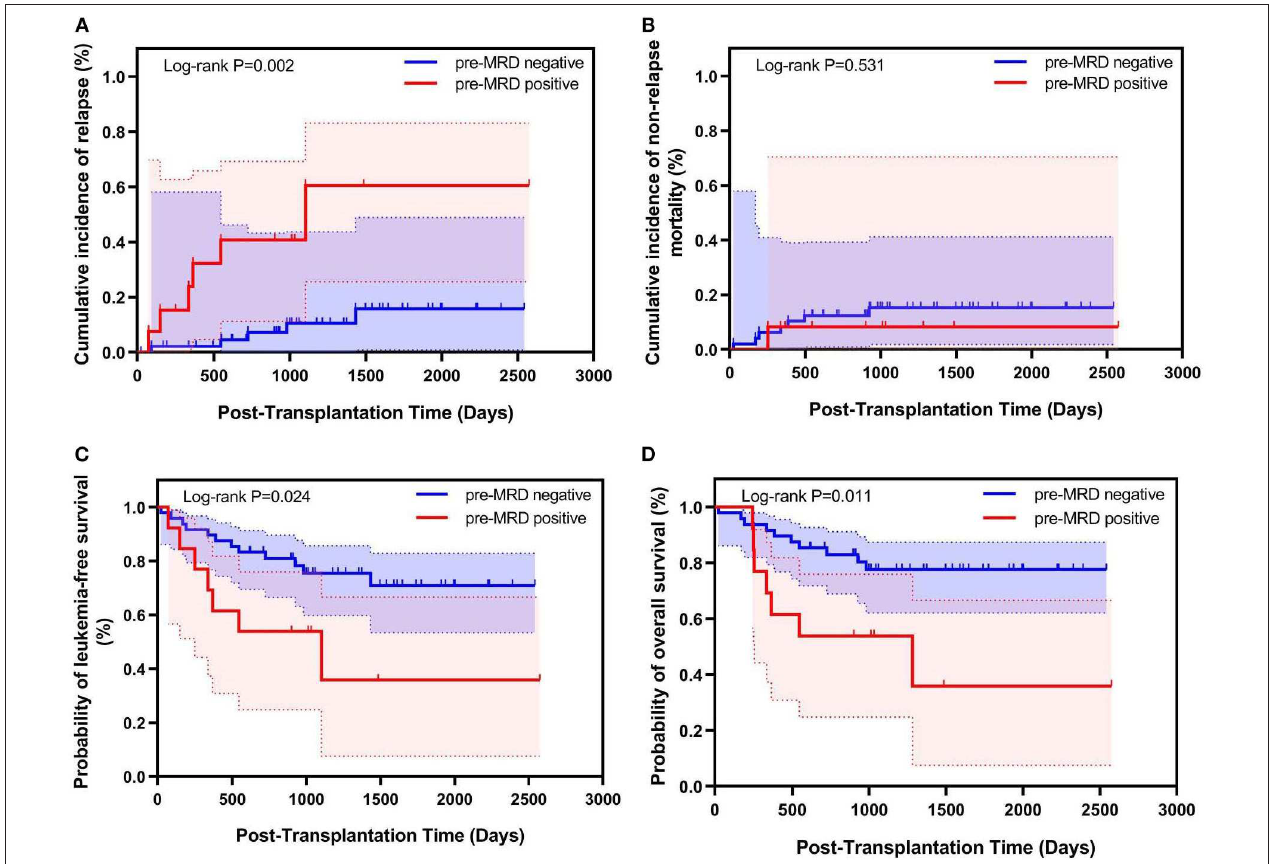
FIGURE 2 | Relationship between pre-transplantation MRD and transplant outcomes for Ph-positive ALL patients who underwent MSDT ( n = 61). Kaplan–Meier estimates of (A) cumulative incidence of relapse mortality, (B) cumulative incidence of non-relapse, (C) leukemia-free survival, and (D) overall survival.